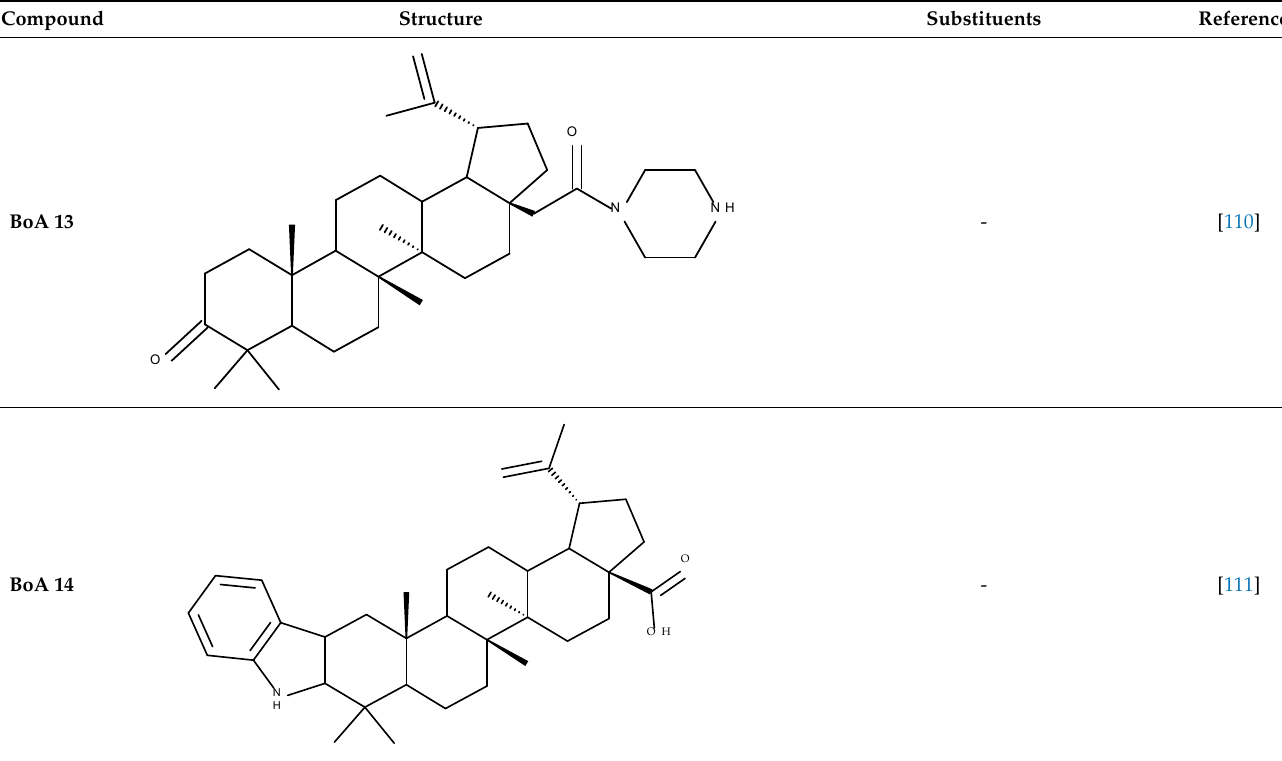
Figure 7. Frequent targets for the derivatization of ursolic